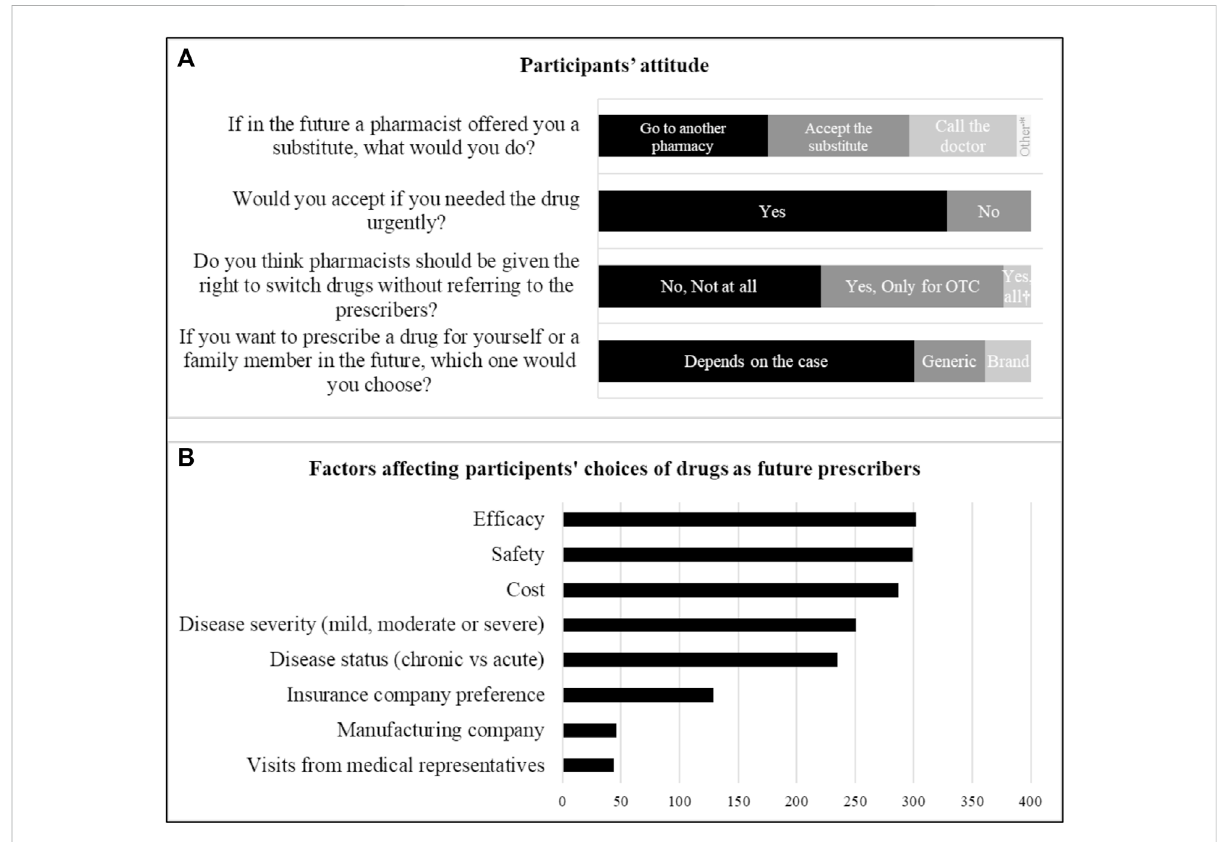
FIGURE 1 Participants ’ attitude. Participants were asked about (A) their future actions as patients, their attitude towards pharmacists ’ rights, their future choiceofdrugsaspatientsand (B) thefactorsaffectingtheirchoiceofdrugsasfutureprescribers( N =390).*Participantsstatedthattheycandecide about the substitute offered by the pharmacists without referring to the doctor. † Pharmacists should be given the right to do independent substitution on all drug